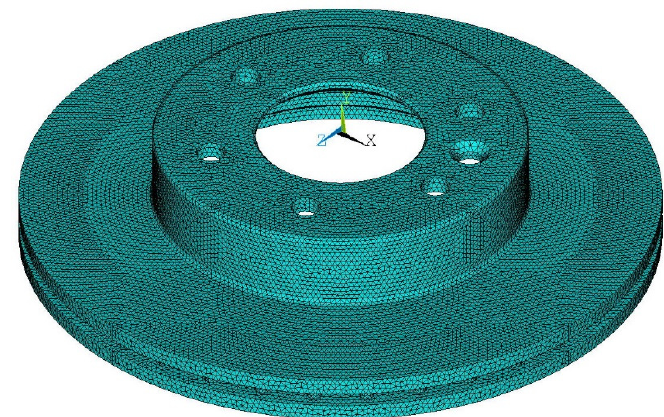
Figure 7. Finite element grid of the baseline model.